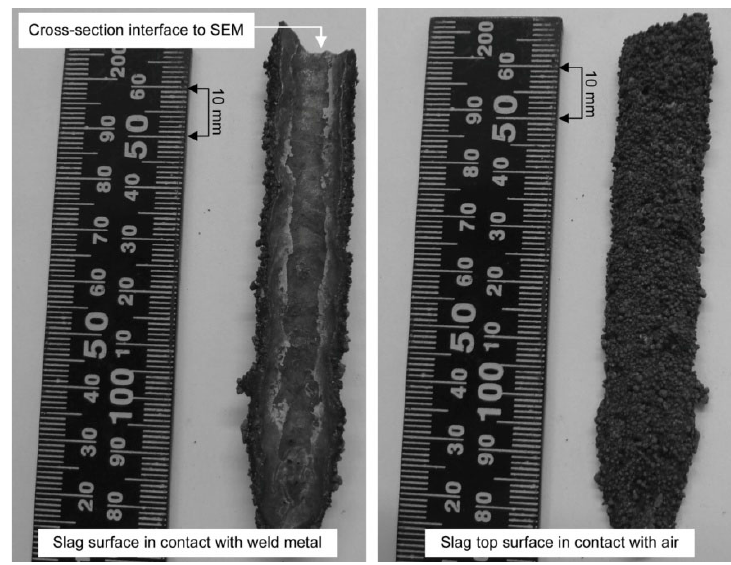
Figure 4. Photographs of post ‐ weld slag ribbon from MP9 weld.